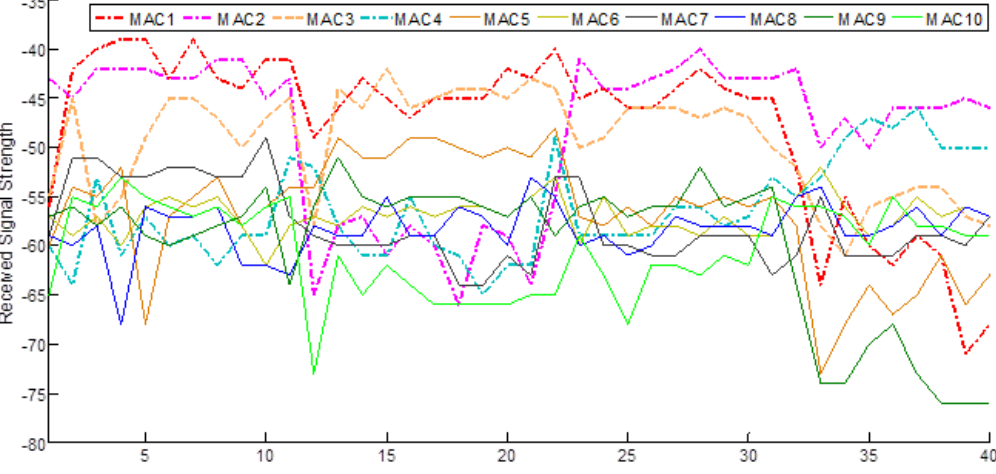
Figure 4. Signal strength data of 10 available APs for an RP.